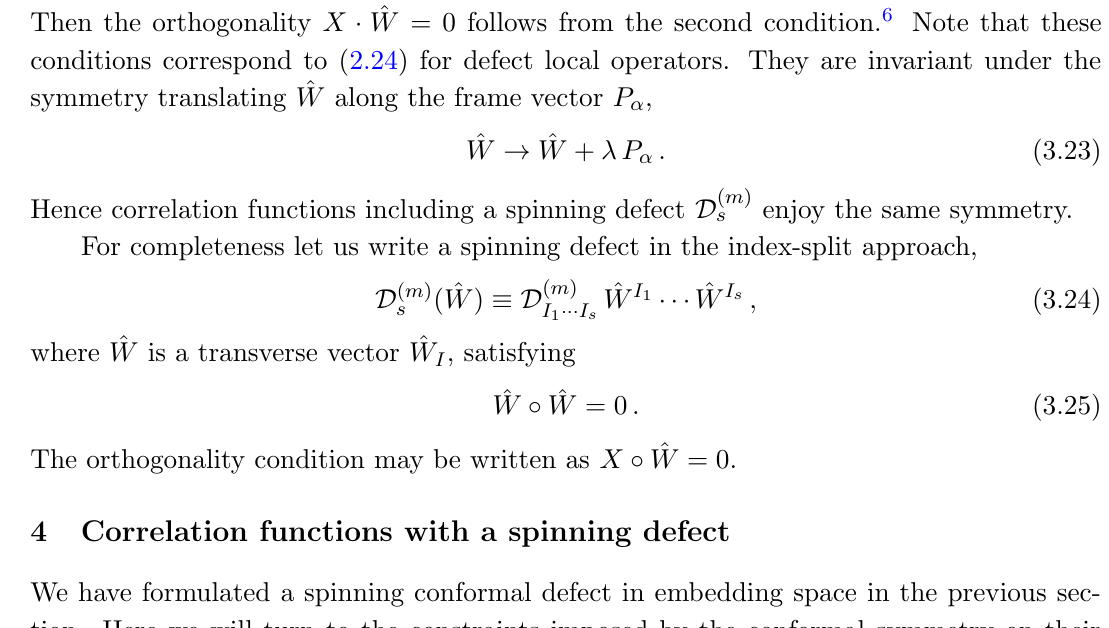
Figure 2 . A spinning defect of codimension- m has a transverse spin under the rotation group SO( m ) acting on the transverse